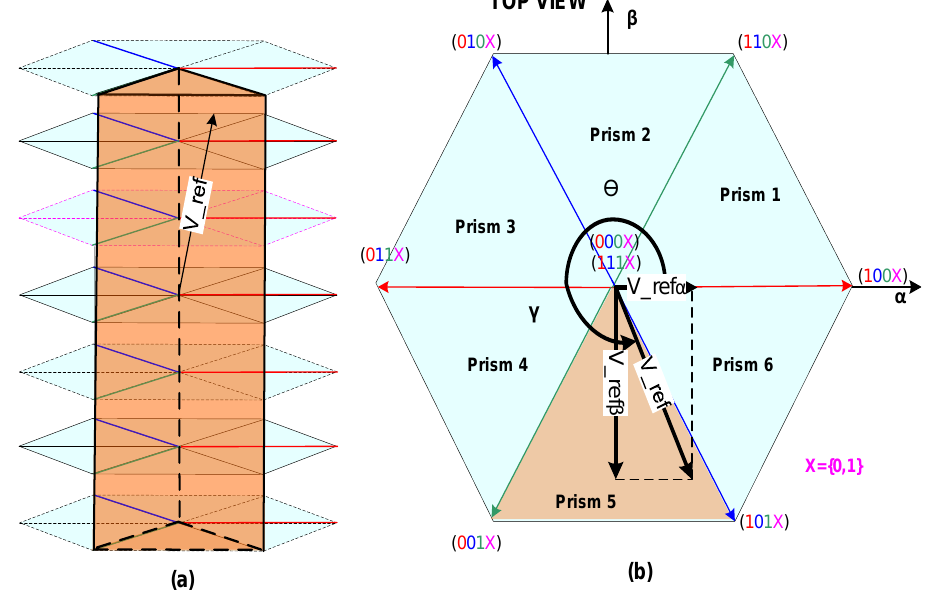
Figure 4. Switching Space Vectors in α-β-γ frame: ( a ) 3D-View ( b ) Top View.